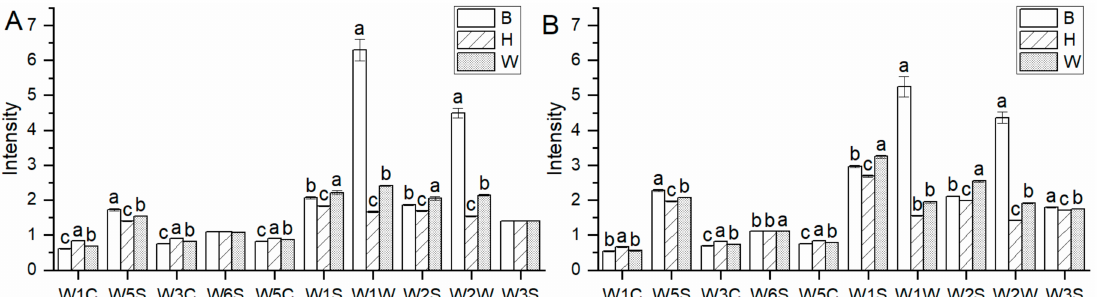
Figure 1. Electronic nose histograms with 10 sensors of egg yolks and albumen from three breeds. ( A ) Electronic nose histogram of yolks. ( B ) Electronic nose histogram of albumen. B, Beinong No.2; H, Hy-Line Brown; W, Wuhei. a,b,c means a sensor with no common letters significantly differs ( p < 0.05) ( n =